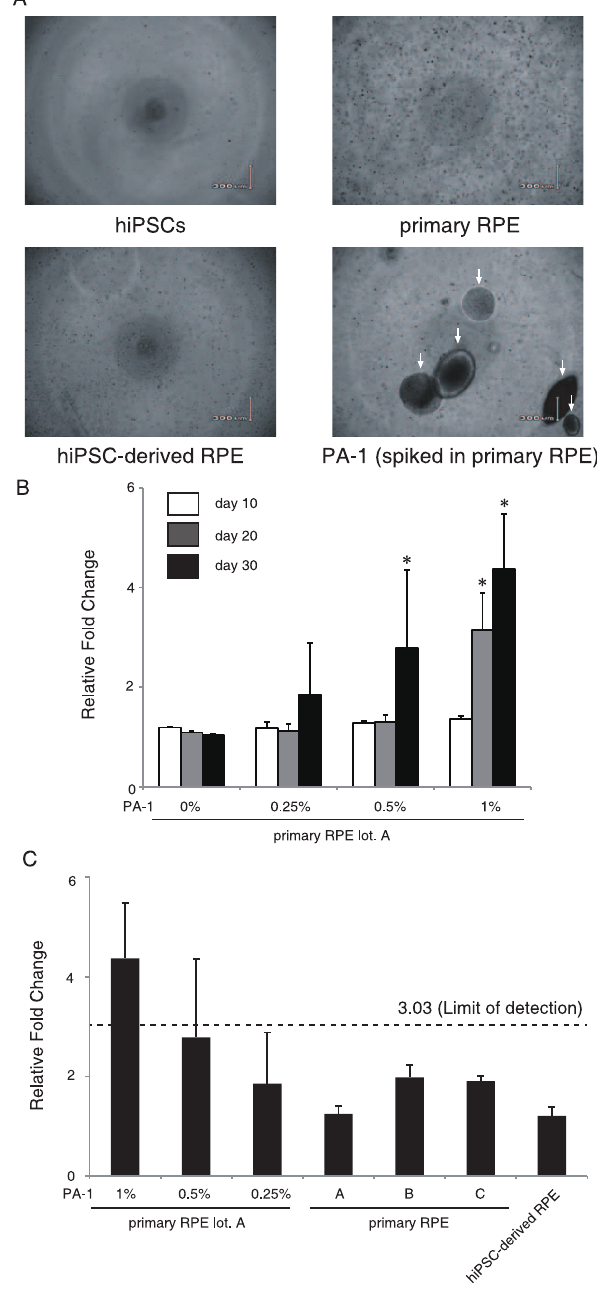
Figure 2. Soft agar colony formation assay of hiPSCs and teratocarcinoma PA-1 cells. (A) Phase-contrast images of hiPSCs, primary RPE cells, hiPSC-derived RPE cells and PA-1cells spiked into primary RPE cells (1%) cultured in soft agar medium for 30 days. Arrows indicate the colonies of PA-1 cells. (B) PA-1 cells (1%, 100 cells; 0.5%, 50 cells; 0.25%, 25 cells; 0%, 0 cells) were spiked into 1.0 6 10 4 primary RPE cells and grown in soft agar for 10, 20 and 30 days. Cell growth was quantified using a CytoSelect kit. Results were expressed as a relative fold change of the value of blank well. Statistical significance was determined using two-way ANOVA and Bonferroni’s post-hoc test (* P , 0.05 compared with the 0% control). (C) HiPSC-derived RPE cells, three lots of primary RPE cells and PA-1 cells spiked into primary RPE cells were grown in soft agar for 30 days. Quantification of the results is described in (B). Limit of detection was calculated as the mean plus 3.3 fold the standard deviation of the measurement of the three lots of